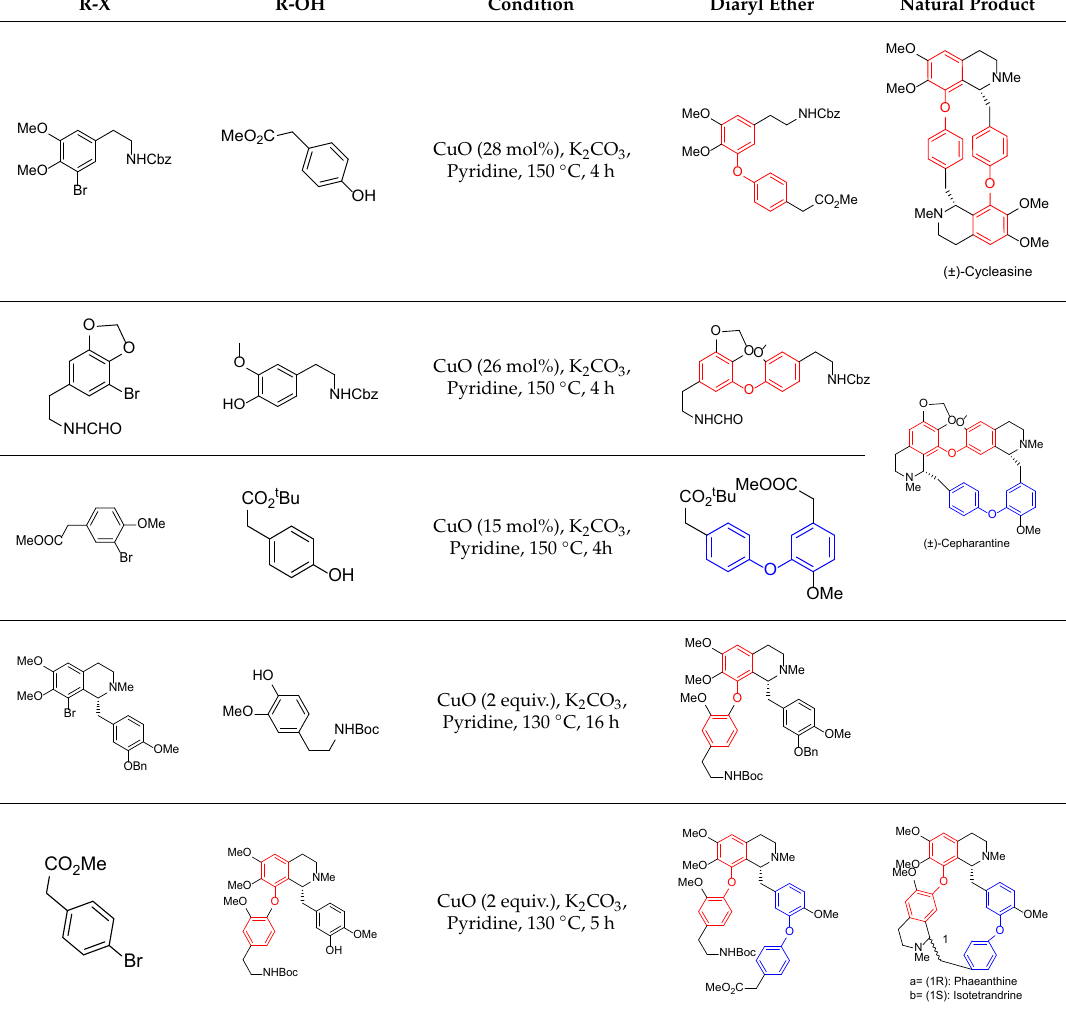
Table 10. The representative example of a natural product using modified methods in cyclic isodityrosine natural products. Compound Condition Structure